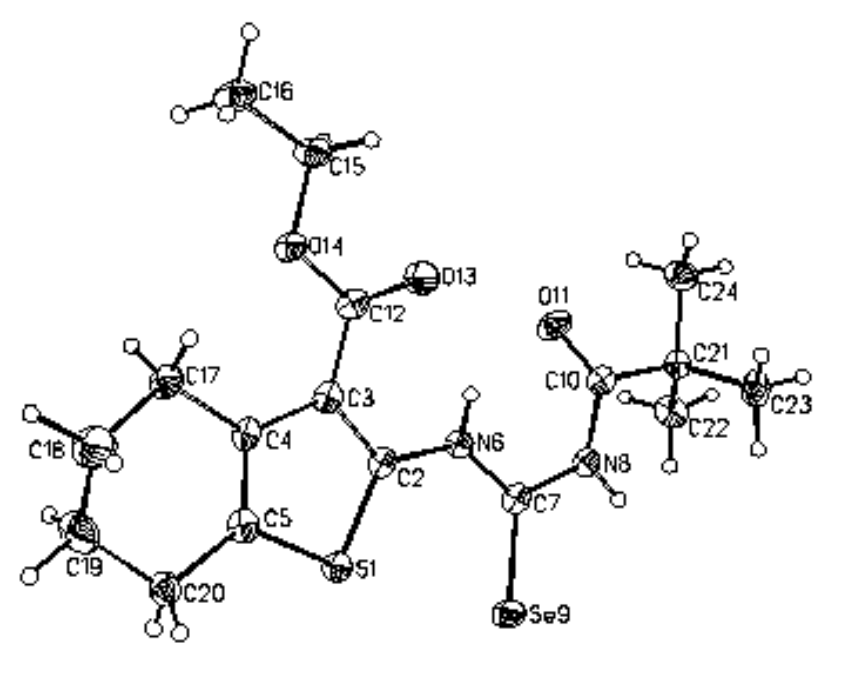
Figure 2. Molecular structure of 2 according to the X-ray analysis.